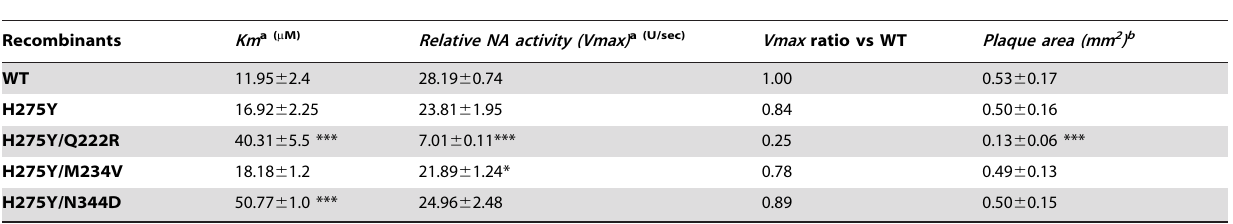
a Values indicate mean Km and relative NA activity ( Vmax) values of a representative experiment performed in triplicate 6 standard deviations (SD). b Values indicate mean plaque area (N=16) 6 SD. *P , 0.05, ***P , 0.001 compared to